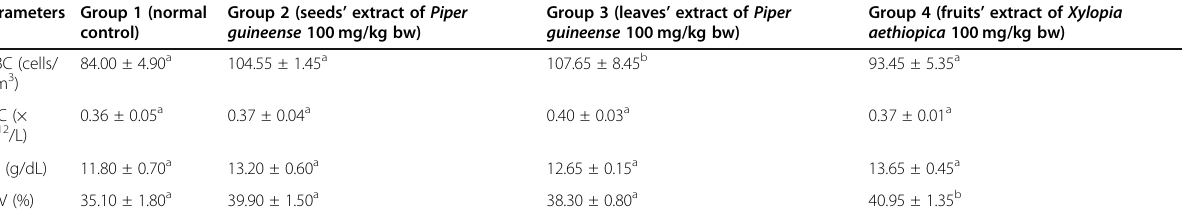
Results represent mean ± standard deviation of group serum results obtained ( n = 5). Means in the same row, having different letters of the alphabet, are statistically significant ( p < 0.05). The result for WBC showed that the increase in group 3 is statistically significant ( p < 0.05) compared to group 1 (control), while groups 2 and 4 increased non-significantly ( p > 0.05). The level of PCV increased significantly in group 4 but increased non-significantly in groups 2 and 3 when compared to group 1. RBC and Hb levels increased non-significantly ( p > 0.05) in all the groups compared to group